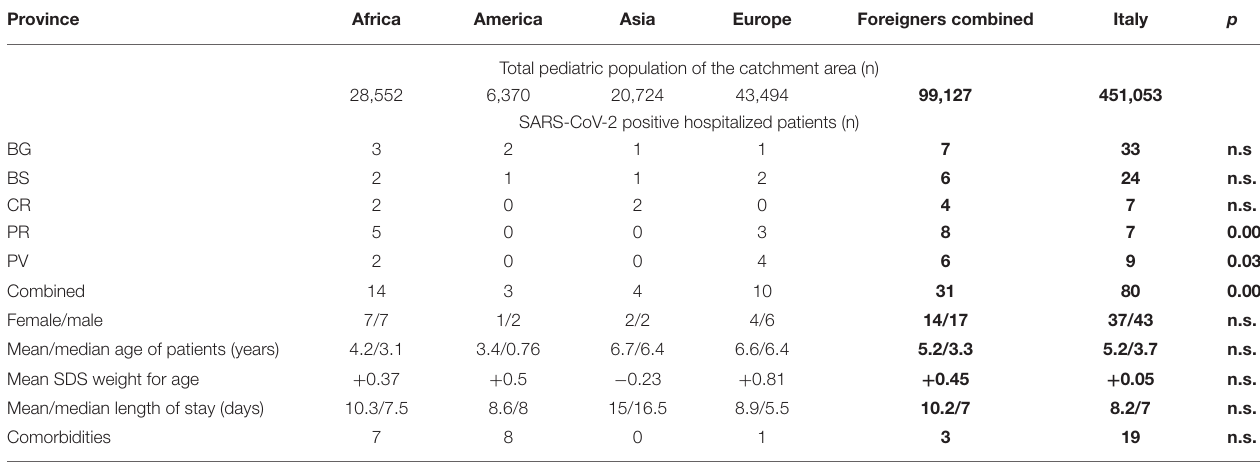
TABLE 2 | Shows the demographic distribution of the study population, clinical data of the hospitalized patients, and the results of the statistical analysis between all foreign patients combined vs. the Italian citizens (BG, Bergamo; BS, Brescia; CR, Cremona; PR, Parma; PV, Pavia; n.s., not statistically significant; SDS, standard deviation